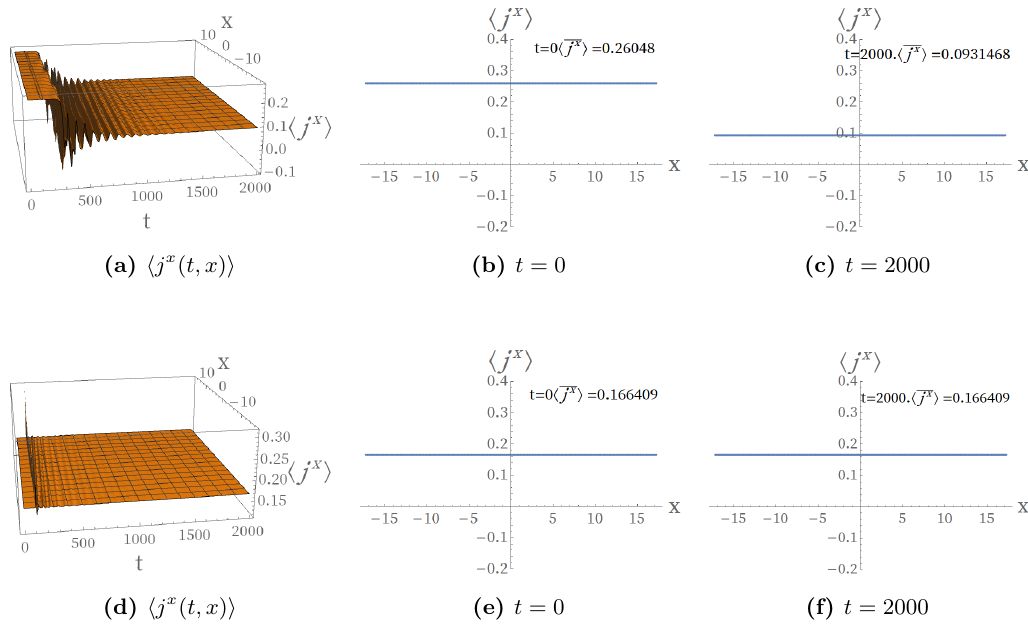
Figure 7. Evolutions for superflows with k = 0 . 3 (stable) and k = 0 . 75 (unstable), respectively. These panels show the particle current density with t ∈ [0 , 2000]